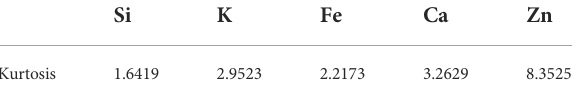
TABLE 1 First order differential distribution kurtosis values for the fi ve substances. Si